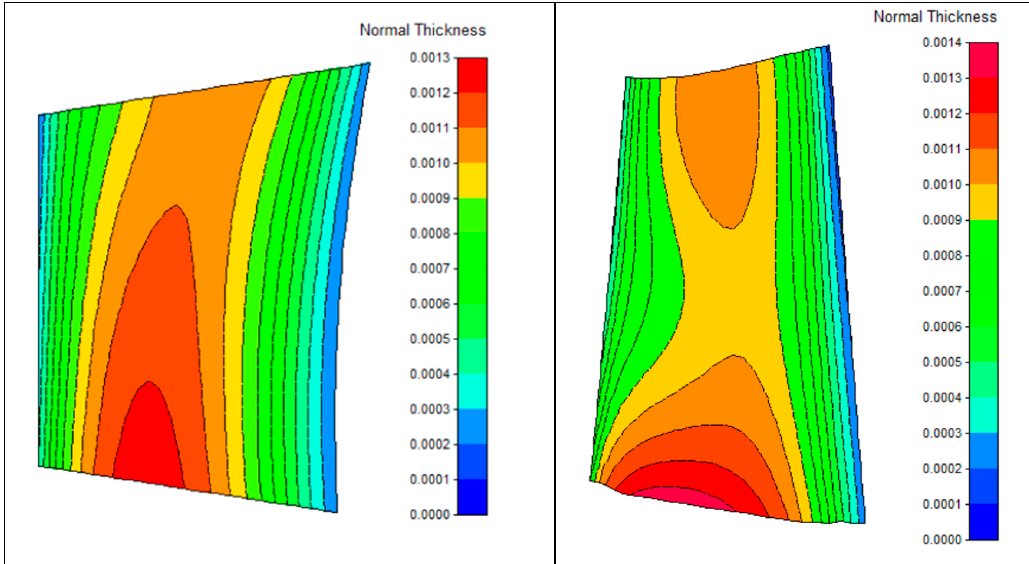
Figure 13. Meridional optimised blade thickness contours (m) for (left) stator (right) rotor.